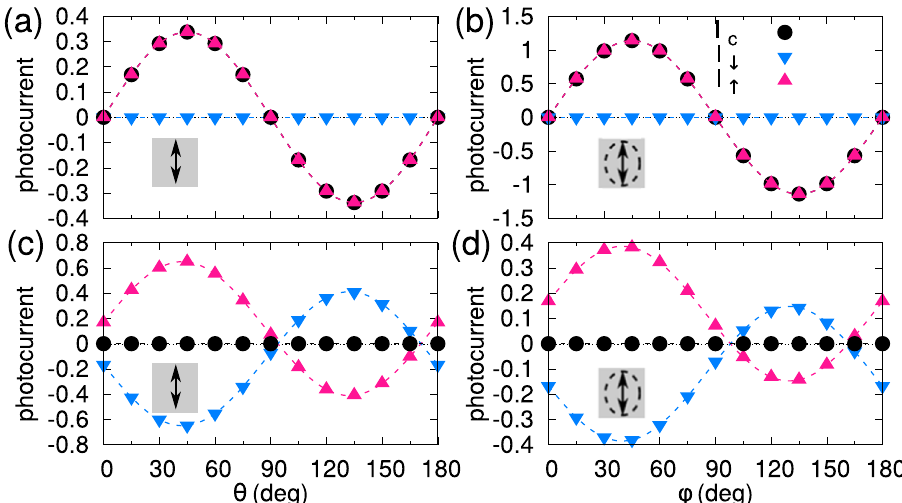
Fig. 5 Photocurrent in “ PP ” and “ PN ” con fi gurations. The spin-up ( I ↑ ), spin-down ( I ↓ ) photocurrent, and total charge photocurrent ( I c ) under LPL and EPL with photon energy E ph = 0.65 eV a , b in con fi guration “ PP ” and c , d in “ PN ” con fi guration at V g = 12 V,